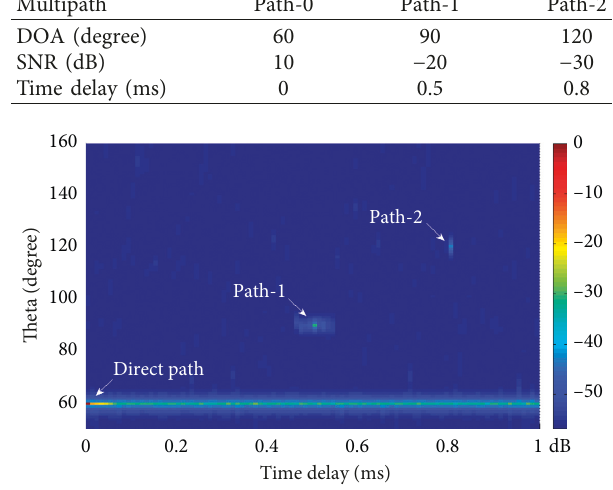
Figure 2: DOA-time-shift spectrum.